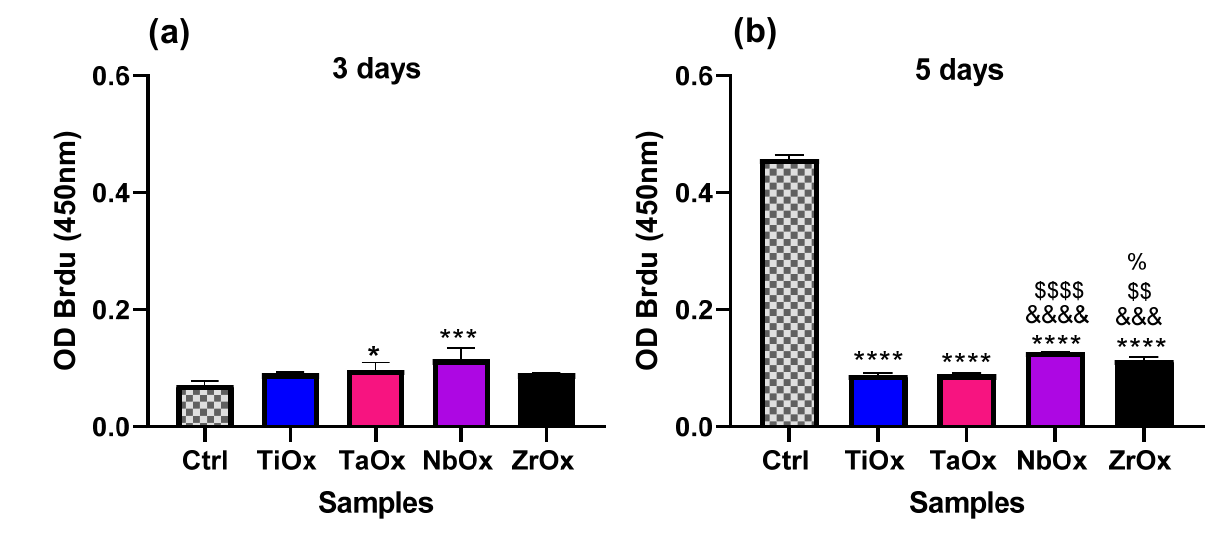
Figure 8. Evaluation of cell proliferation for BM-MSC cultured on the coatings studied. ( a ) 3 days and ( b ) 5 days of culture. The Roche Cell Proliferation ELISA, BrdU (colorimetric) kit was used. Ctrl corresponds to BM-MSC cultured on standard TCP. Data are presented as the mean ± standard error using three independent cultures per variable and analyzed by one-way ANOVA using a Dunnett’s post hoc test. * p ≤ 0.05 vs. Ctrl; *** p ≤ 0.005 and **** p ≤ 0.0005; &&& p ≤ 0.001 vs. TiOx; &&&& p ≤ 0.0001 vs TiOx; $$ p ≤ 0.01 vs. TaOx; $$$$ p ≤ 0.001 vs. TaOx; % p ≤ 0.05 vs. NbOx.